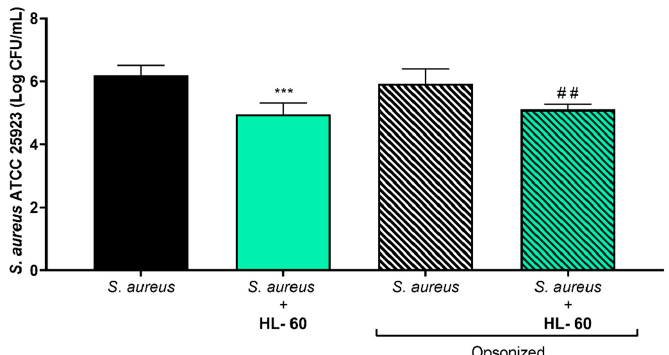
Figure 3. Viable counts of adhered opsonized and nonopsonized S. aureus ATCC 25923 on titanium coupons after coculture with HL-60 cells for 24 h. The left half of the graph includes the nonopsonized S. aureus ATCC 25923 biofilm formation, in absence (black column) or cocultured with HL-60 cells (green column). The right half includes the opsonized S. aureus ATCC 25923 biofilm formation, in absence (white/black column) or cocultured with HL-60 cells (green/black column). “*” indicates statistical differences with the nonopsonized S. aureus ATCC 25923 in monoculture, while “#” represents statistical differences with the opsonized S. aureus ATCC 25923 in monoculture with Welch’s unpaired t -test ( *** p < 0.001; ## p < 0.01). Values are means and SD of three independent